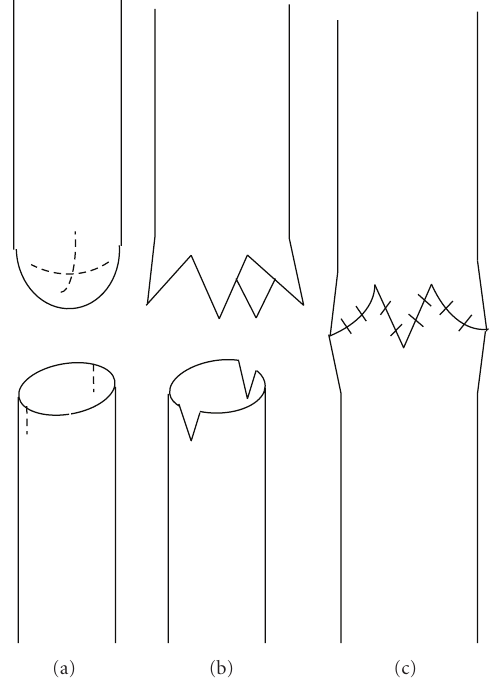
Figure 2: (a) Plus incision onto the blind pouch and small incisions to the distal esophagus bilaterally, (b) the opened state of both ends after incision, (c) view of the anastomosed